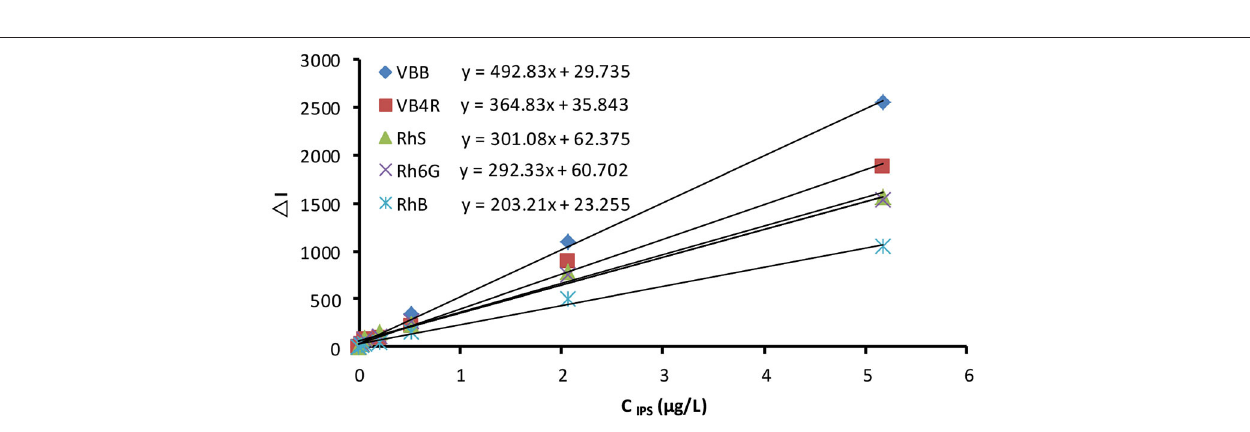
FIGURE 6 | Working curve for the SERS determination of Apt–C 60 OH–AgNO 3 -TSC-IPS. 20.67 nmol/L Apt + 0.05–5 µ g /L IPS + 266.67 µ g/L C 60 OH + 1.33 mmol/L AgNO